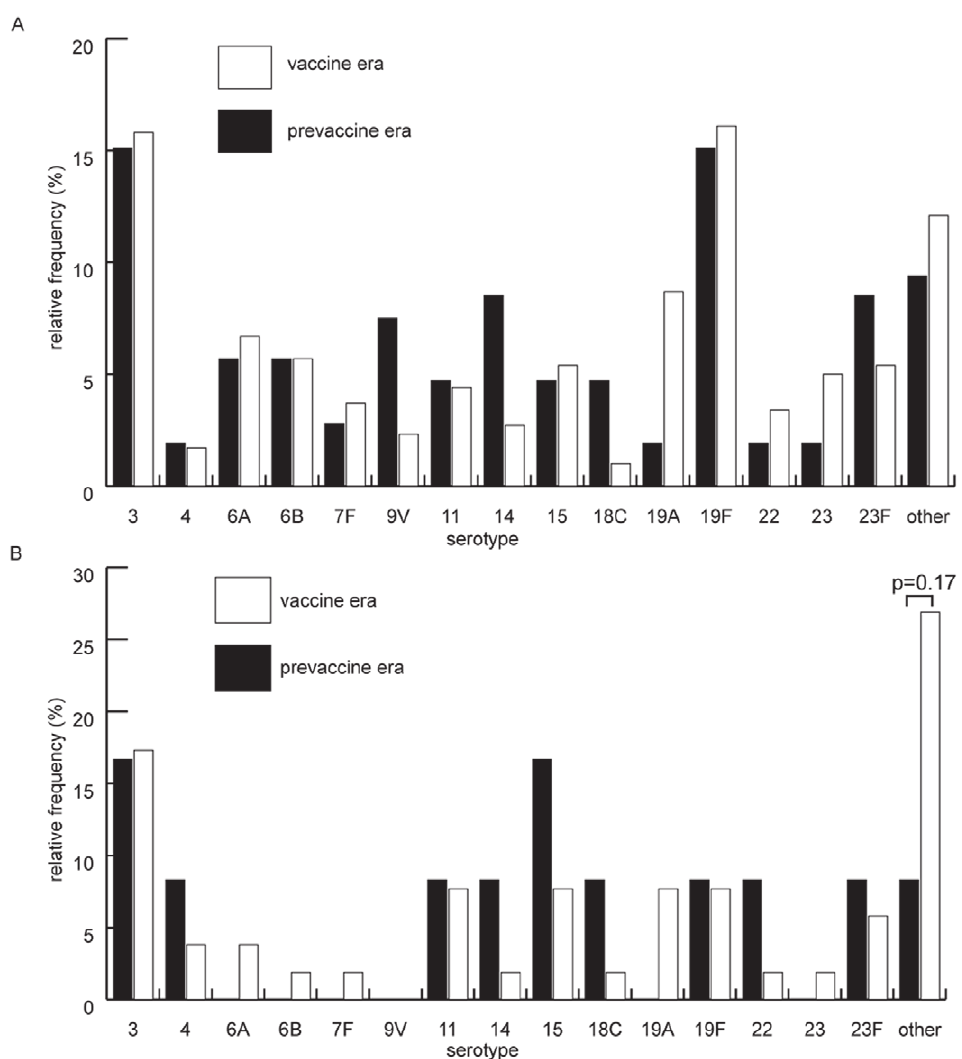
Figure 3. Relative distribution of pneumococcal serotypes among 468 pneumococcal strains isolated in prevaccine or vaccine era. The relative frequency of pneumococcal serotypes isolated from nasopharyngeal swabs before and after the introduction of the seven-valent conjugated polysaccharide vaccine for ( A ) swabs with one serotype only (prevaccine era n 106, vaccine era n 298), and ( B ) restricted to isolates from cocolonized samples (prevaccine era n 12, vaccine era n 52). For easier reading of the graph rare serotypes (prevalence , 2%) were grouped as ‘‘others’’. They included serotypes and/or serogroups 1, 8, 9 (except 9V), 10, 16, 17, 17F, 18 (except 18C), 20, 21, 28, 33, 34, 35, 38 and non-typeable isolates.